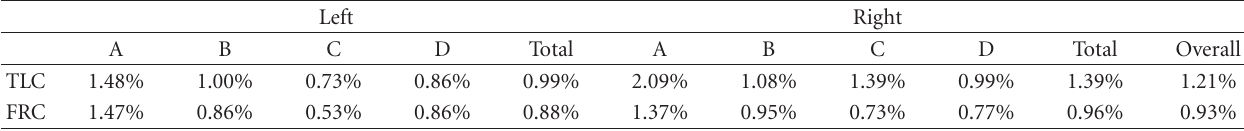
Table 2: False positive rate in TLC and FRC